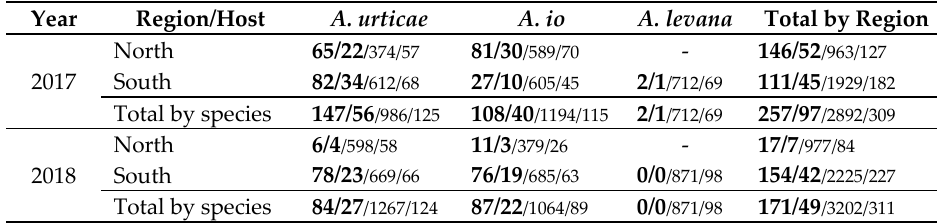
Table 1. Showing by region, year, and butterfly host, and in order, in large font and in bold the number of individuals of P. confusa reared and the number of butterfly nests parasitized by P. confusa , and in smaller font the total number of butterfly host larvae and the number of nests collected. Note that A. levana is not yet present in the northern region.